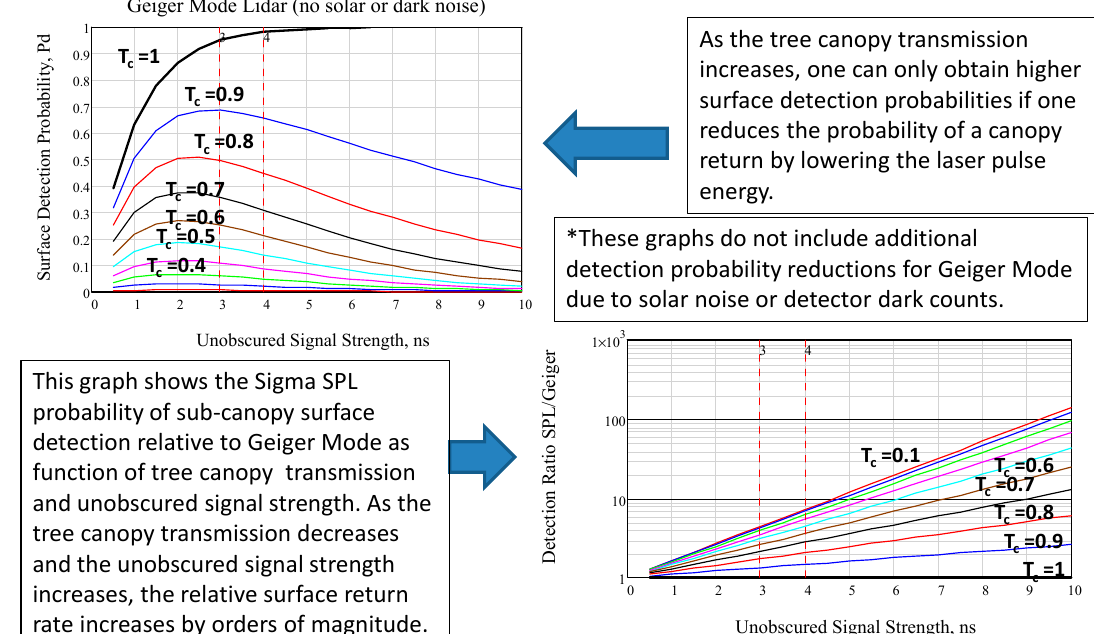
Figure 17. The relative performance of SPL and GM lidars over a wide range of one-way tree canopy transmissions ( T c = 0.1 to 1) A value γ = 1 is assumed. The top left graph demonstrates that, as the tree canopy transmission decreases, the optimum unobscured signal for maximum penetration decreases, further reducing the detectability of the under canopy surface by the GM lidar. The bottom right graph describes the increasing advantages of the SPL technique in detecting the under canopy surface as the one way canopy transmission decreases.